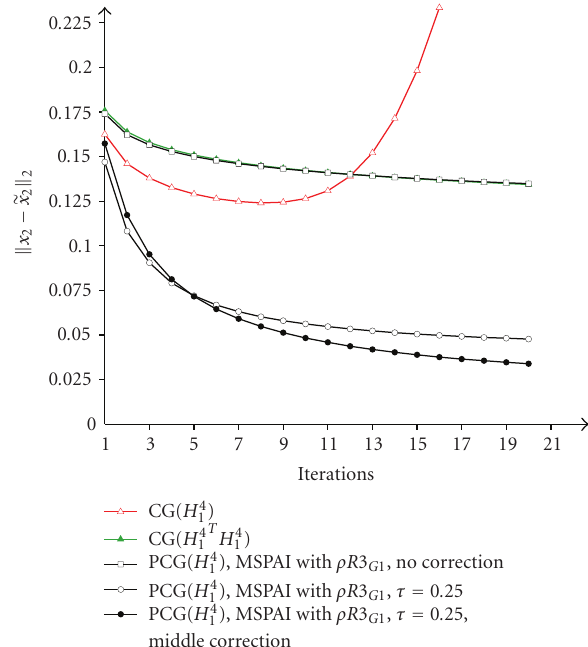
Figure 4: Reconstruction error against the iteration for the 1D blur operator H 4 1 and the original data x 2 of size n = 10 3 a ff ected by random noise of order 0.1%. CG is compared to CG for the normal equations and to PCG using MSPAI satisfying R 3 G 1 with ρ = 10 2 .